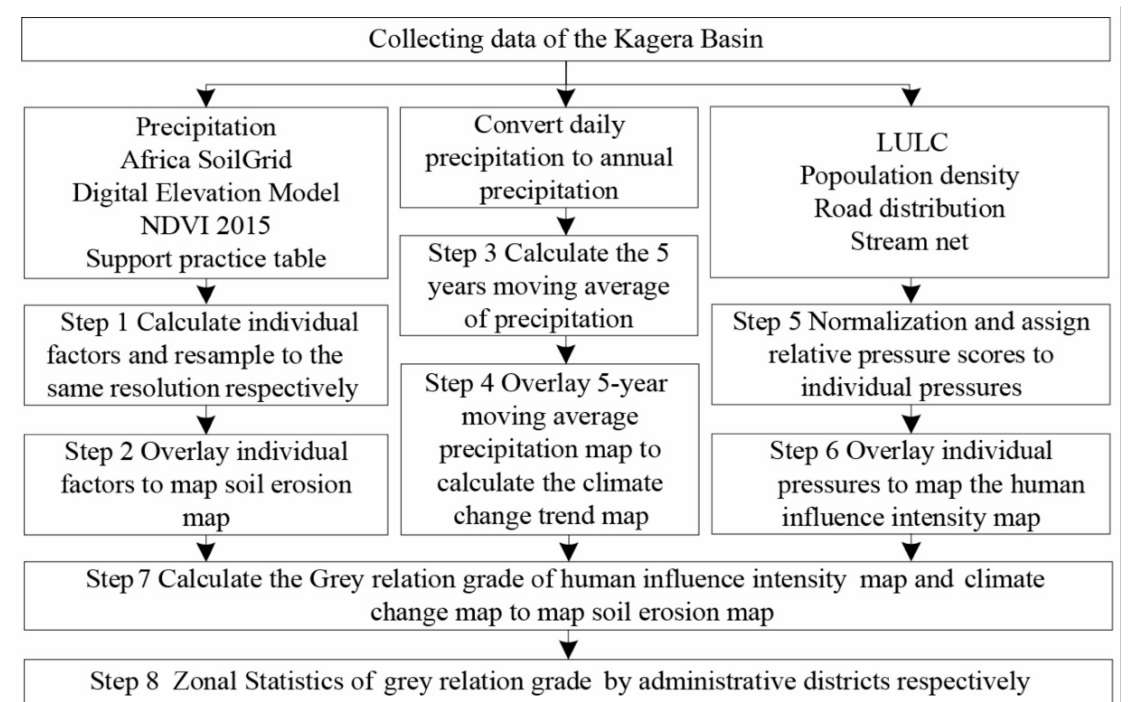
Figure 3. Flowchart depicting the analysis process used in this study. See the text for details about the datasets